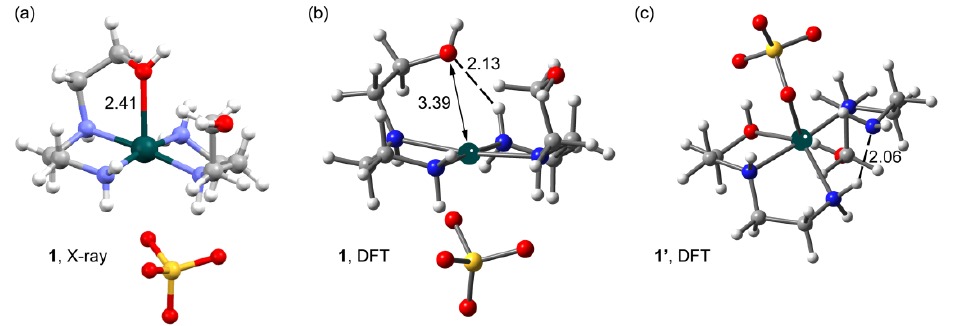
Figure 1. ( a ) X-ray structure of compound 1 ; ( b ) B3LYP-D3/def2-SVP optimized geometry of 1 ; ( c ) B3LYP-D3/def2SVP optimized geometry of 1 ′ (see text). Distances are given in Å. H-Bonds depicted in dotted cyan lines. Atoms colour code: carbon—grey; hydrogen—white; nitrogen—blue; oxygen—red; copper—dark green; sulfur—yellow.